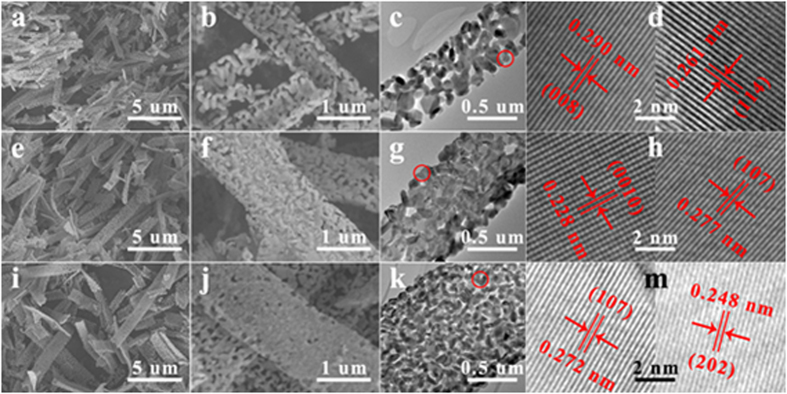
Representative FESEM (the 1st and 2nd columns), TEM (the 3rd column) and HRTEM (the 4th column) images of SrFe12O19 nanoribbons: (a–d) for S1, (e–h) for S2, (i–m) for S3.